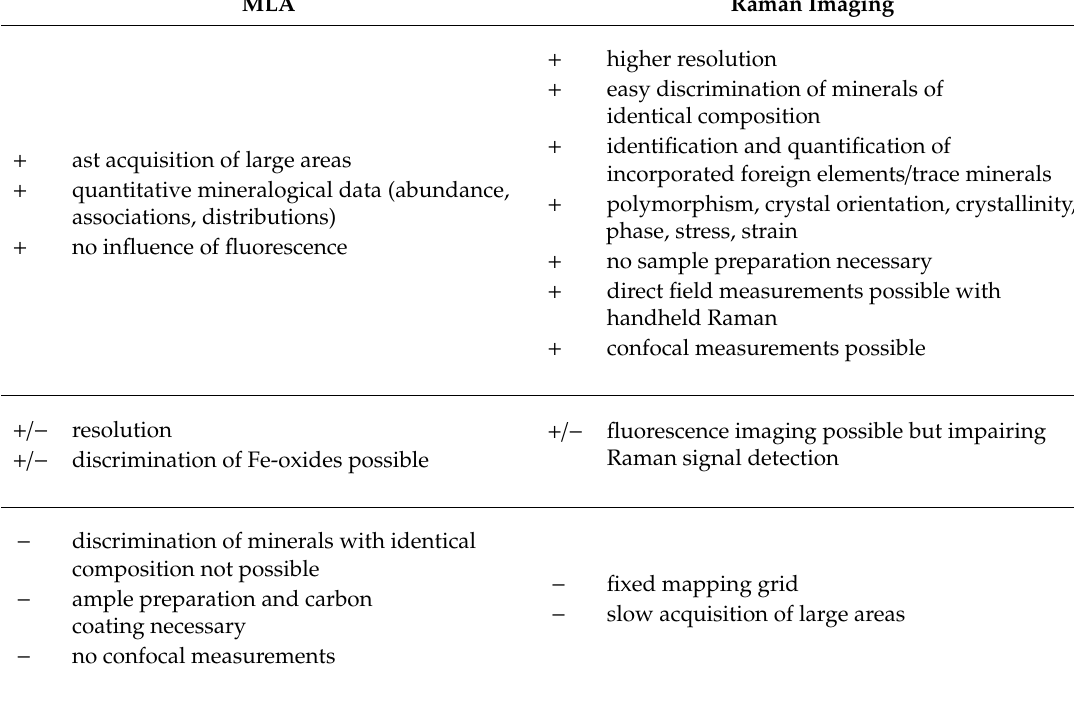
Table 3. Pros and cons of MLA and Raman imaging for characterization of iron